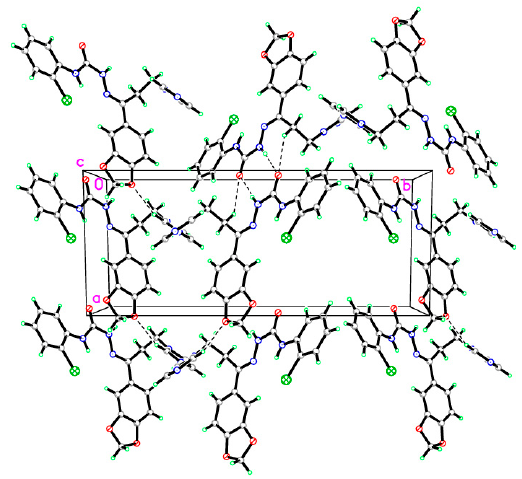
Figure 2. Molecular packing of the semicarbazone 4 manifesting hydrogen bonds which are drawn as dashed lines.